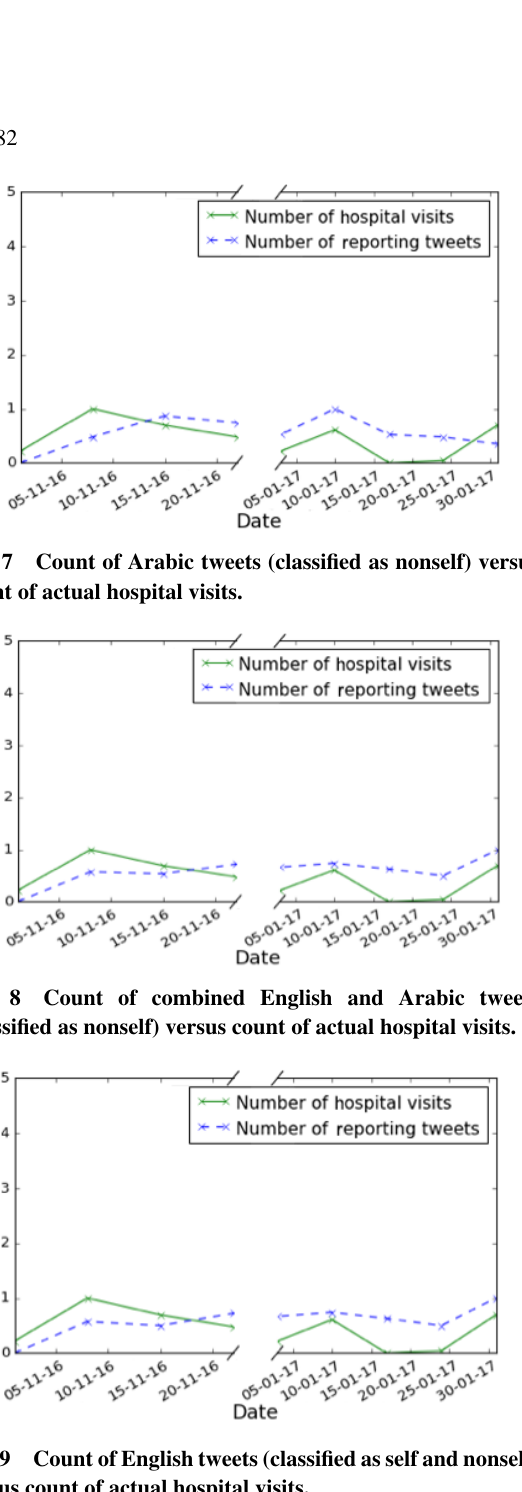
Fig. 9 Count of English tweets (classified as self and nonself) versus count of actual hospital visits.